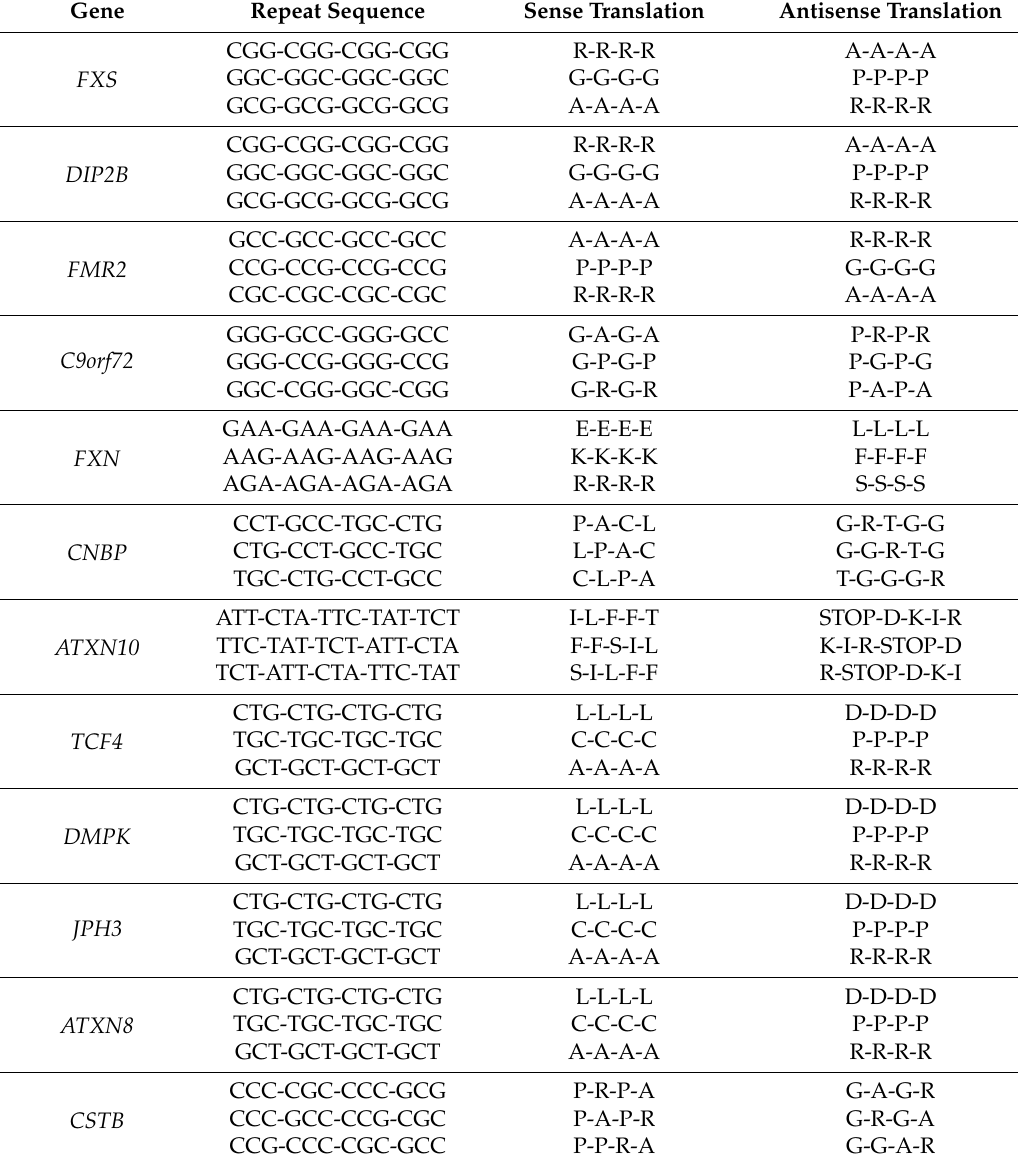
Table 2. Potential translation products of non-coding repeat